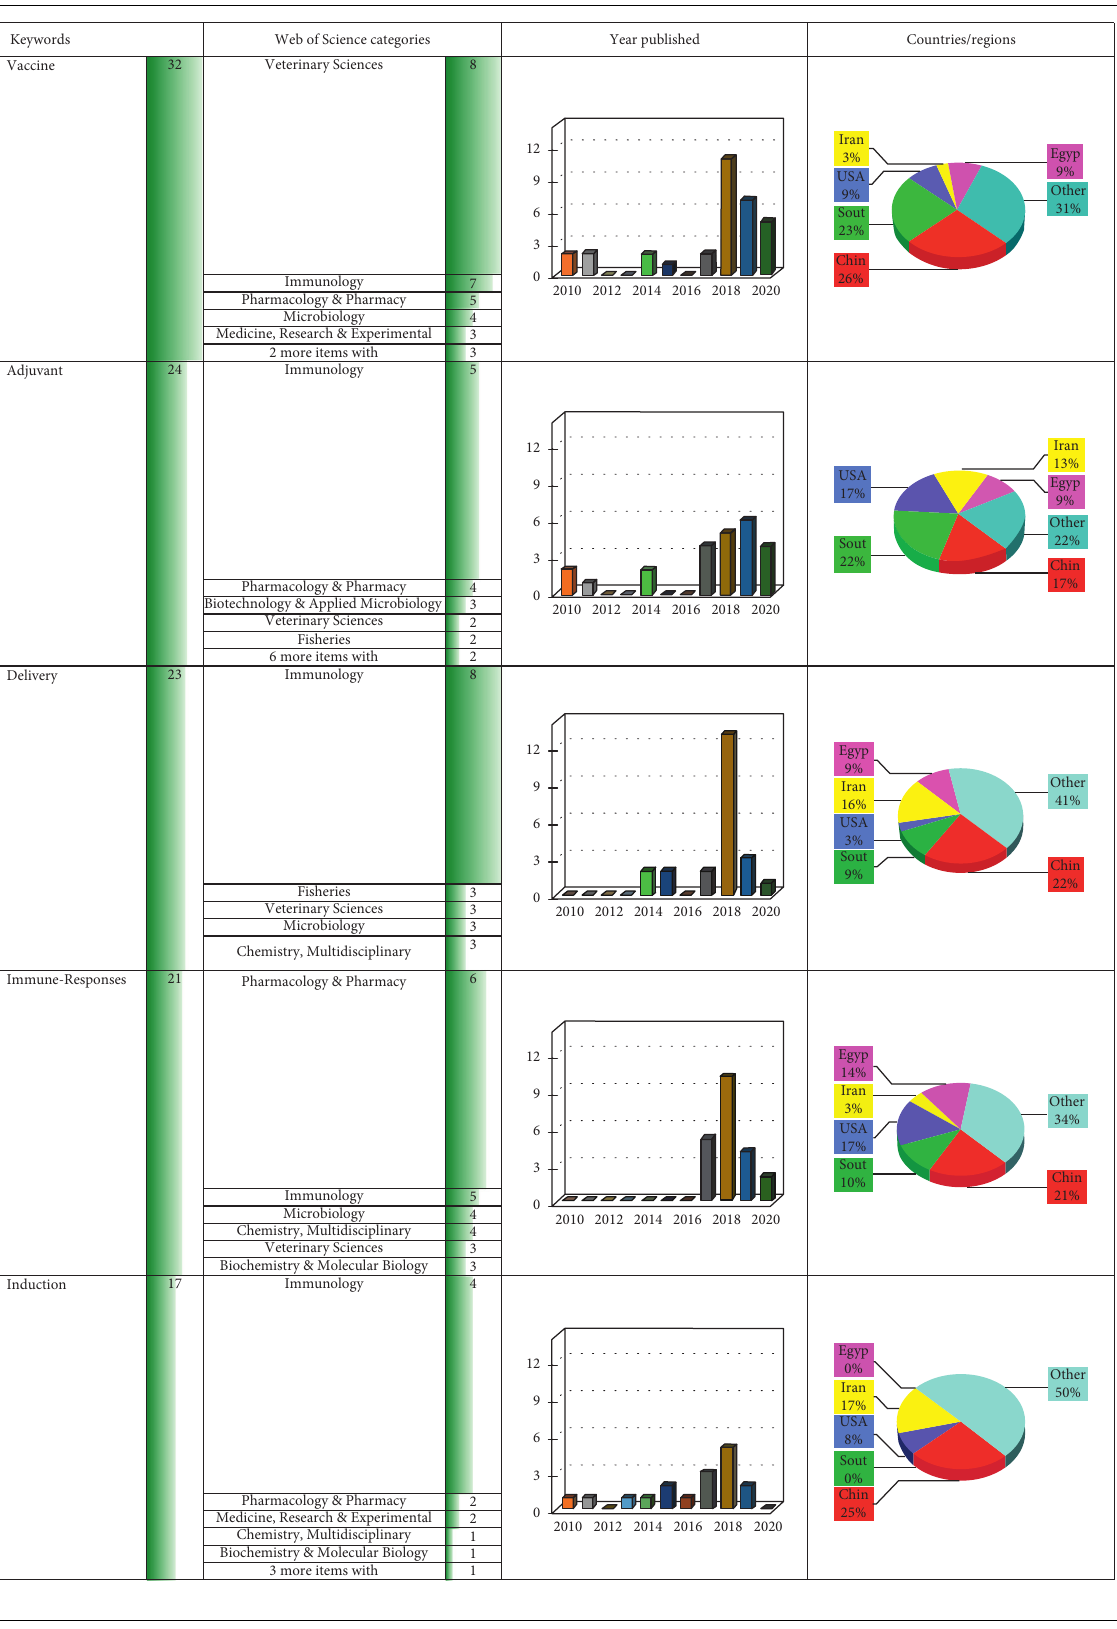
Table 4: Top five high-frequency keywords terms related to chitosan use in immune response and vaccine